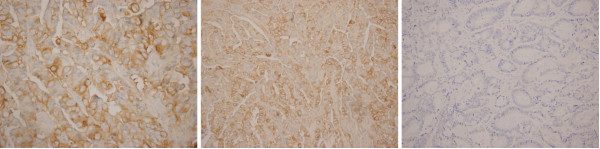
Immunohistochemical staining for HER-2/neu and VEGF (original magnification, × 200). (a) Strong cytoplasmic stain in > 10% of tumor cells. (b) VEGF stained in > 10% of tumor cells. (c) No expression of VEGF and c-erbB-2 in colon cancer.